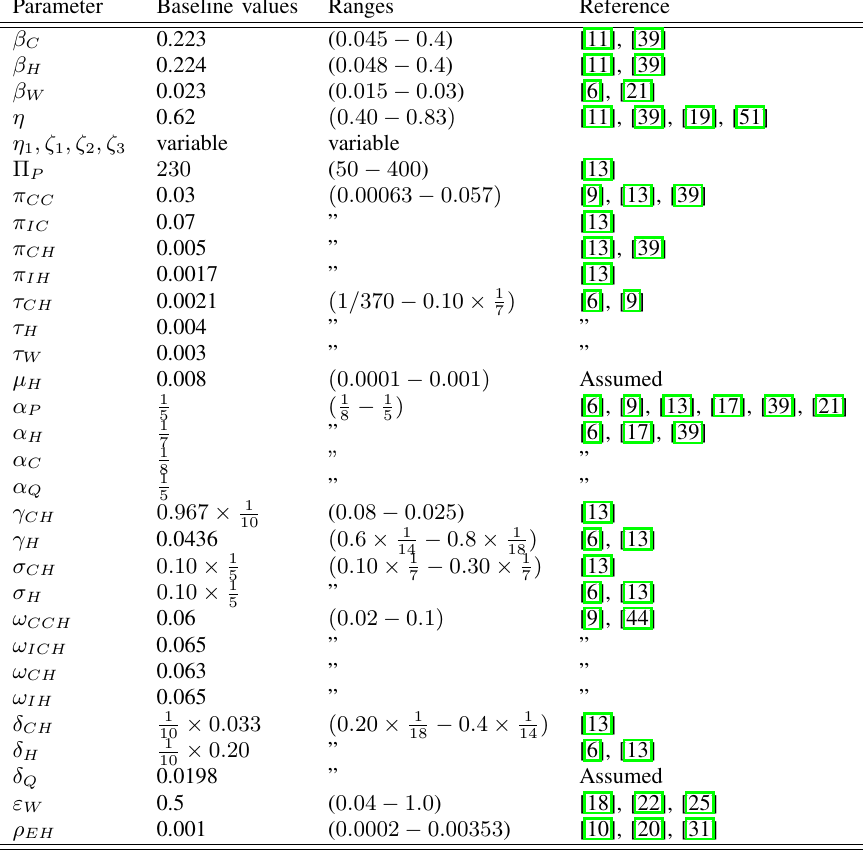
V ALUES AND RANGES OF THE PARAMETERS OF MODEL (2.1). A LL PARAMETERS HAVE UNITS OF DAY − 1 EXCEPT UNITS OF NUMBER PER DAY .